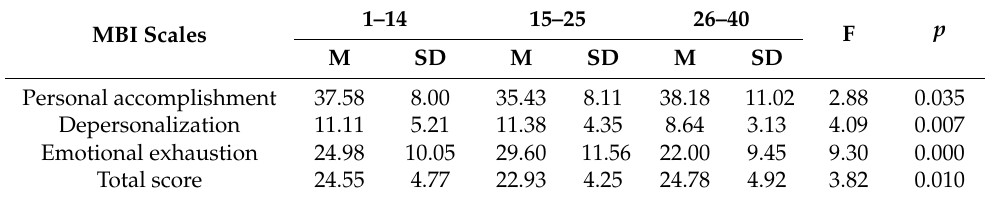
Table 7. Intergroup means comparison for work experience and burnout (total score and individual scales).